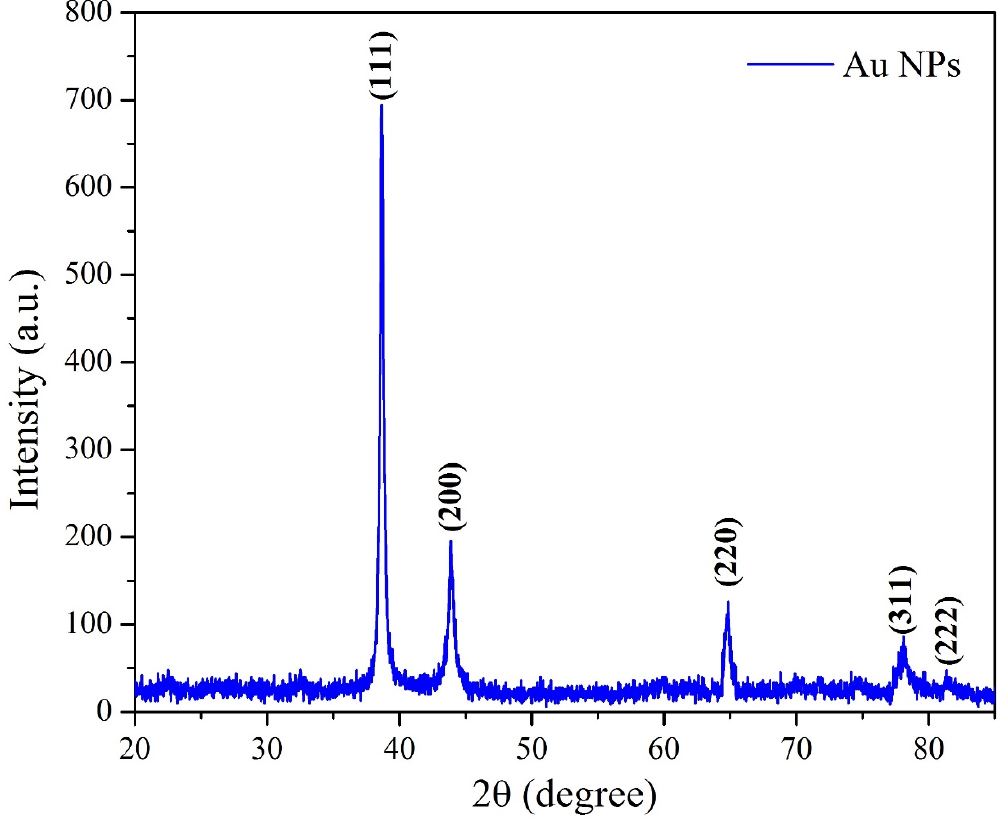
Figure 7. XRD pattern of the synthesized AuNPs.